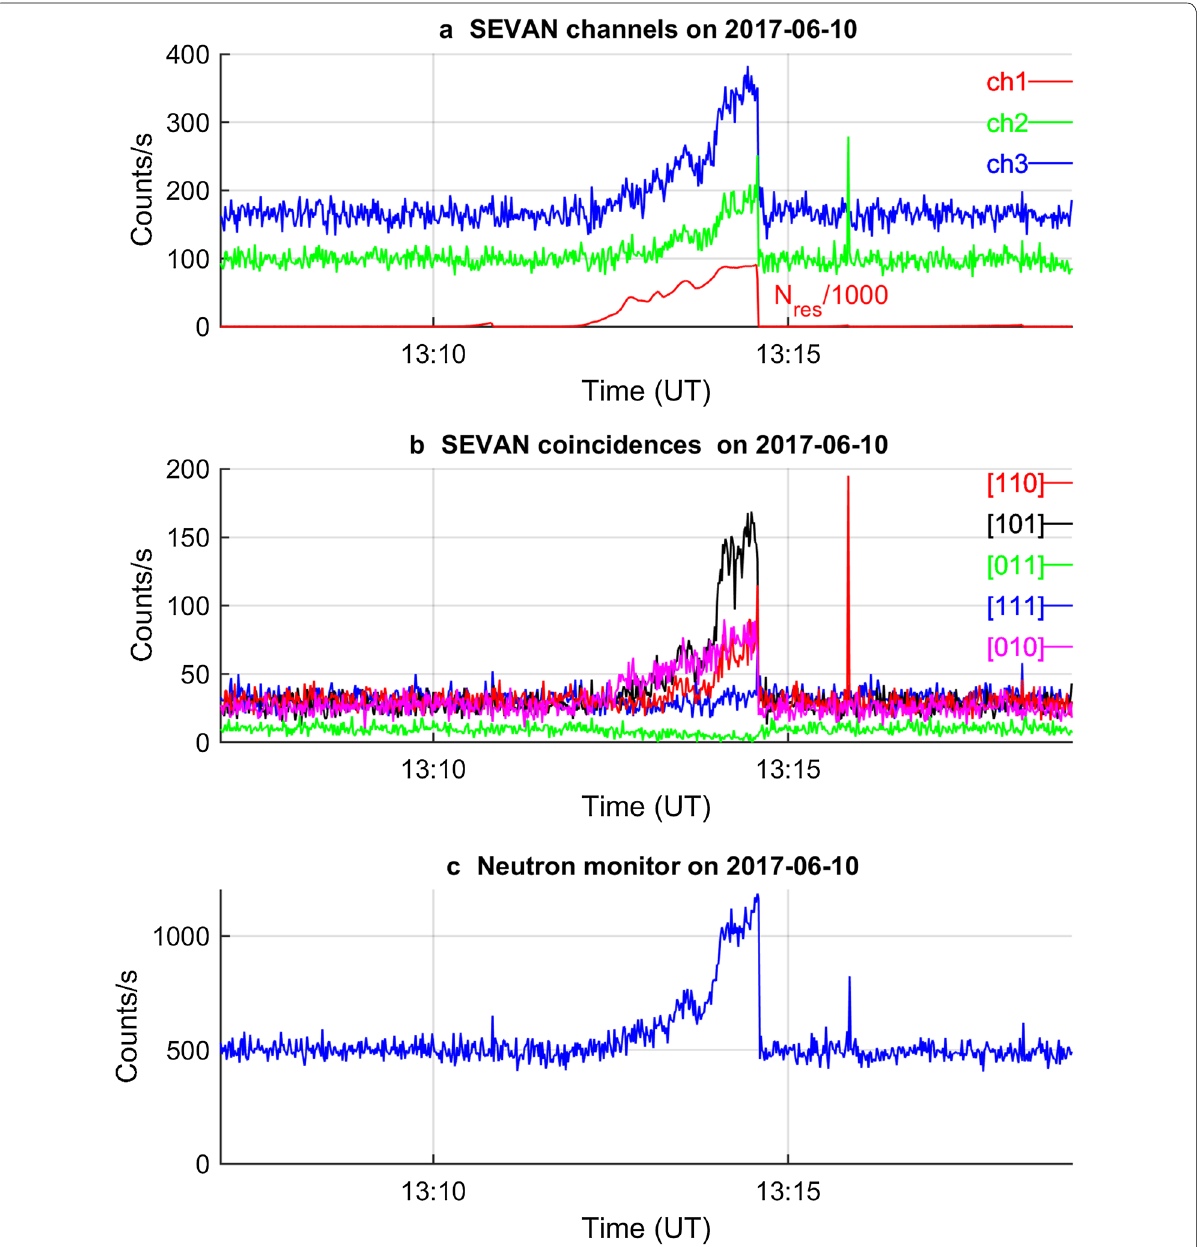
Fig. 11 Extreme event recorded by SEVAN and neutron monitor on 10 June 2017 around 13:13 UT. a Raw counts recorded by individual SEVAN channels. b Coincidences recorded by different combinations of SEVAN channels. c Raw counts recorded by neutron